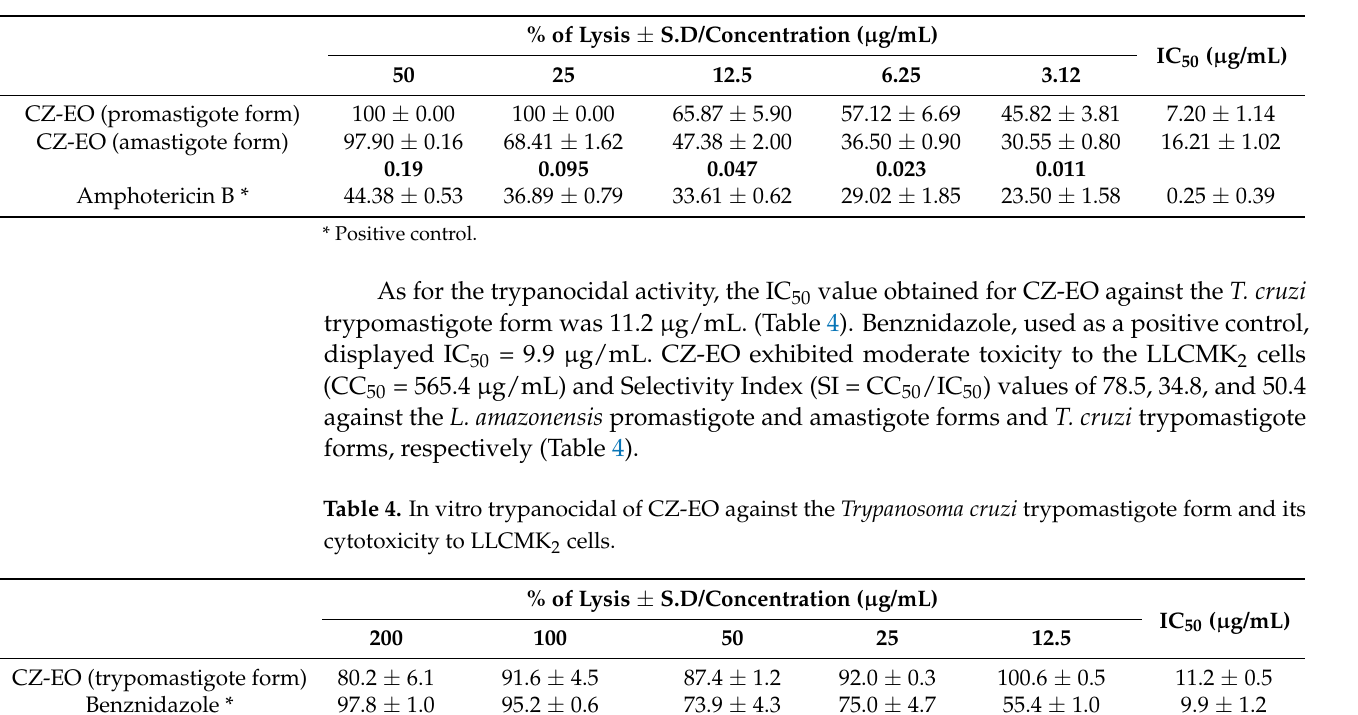
Table 3. In vitro antileishmanial activity of CZ-EO against the L. amazonensis promastigote and amastigote forms.